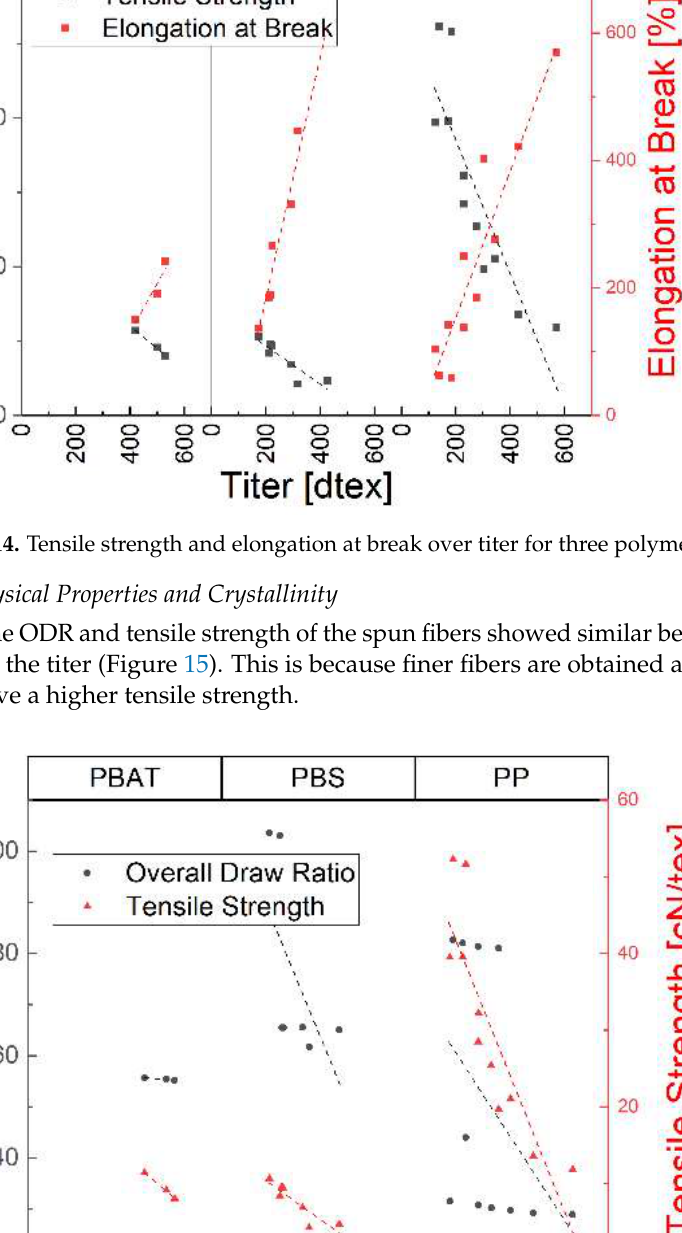
and Mw of PBS are higher than PBAT, but the tenacity is similar. This indicates that the higher Mw of PBS leads to a higher degree of interchain entanglements, which could de- crease the possibility of chain alignment in the melt-spinning process [28]. This means that the achieved tenacity of the PBS fibers could be close to the achievable maximum of PBS, whereas PBAT could be improved in future trials. The higher crystallinity of PBS also increases the alignment of the polymer chains, which is necessary for increasing the te- nacity. This suggests that the spinning process might be improved in future trials for PBS and PBAT. PP showed an approximately five-fold increase in tenacity over the different draw ratios, which is commensurate with the literature values. The titer, tenacity, elonga- tion at break, overall drawing and crystallinity of the fibers are summarized in Table 6.